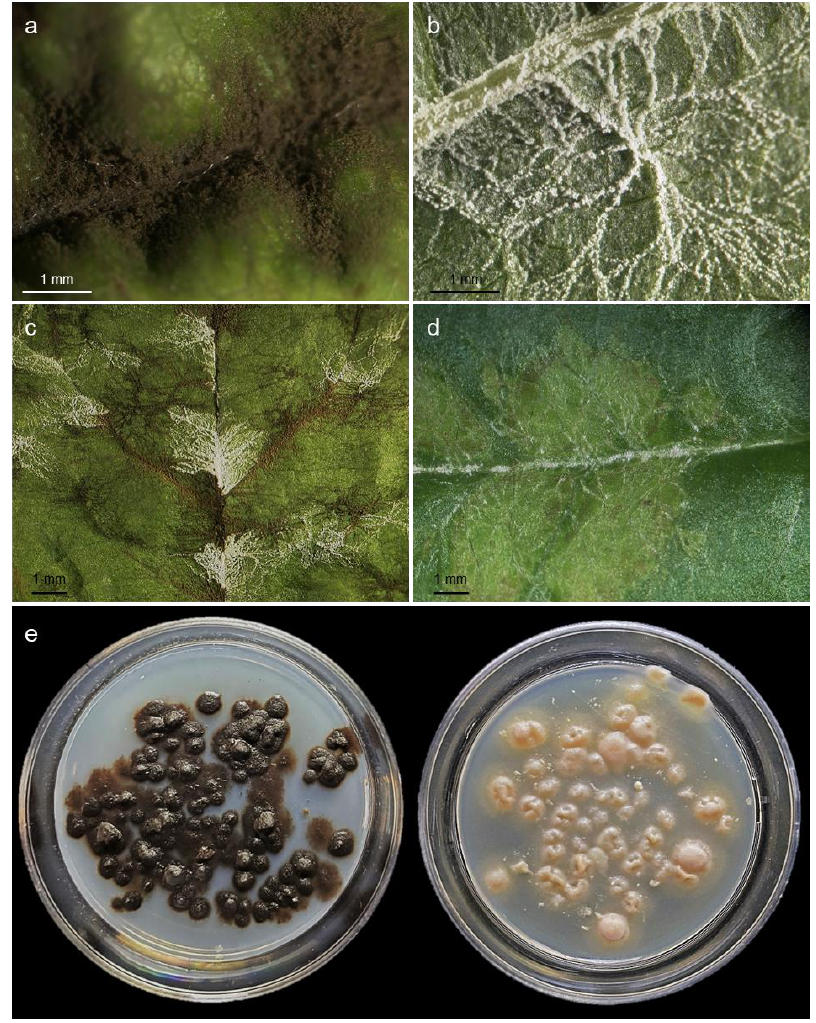
Figure 1. Symptoms of Venturia inaequalis isolate HS1 (wild-type; ( a , c )) and SW01 (melanin-deficient mutant, ( b – d )) on apple leaves. The wild-type produces large numbers of melanised conidia on the leaf surface, 10 dpi ( a ); the melanin-deficient isolate produces white conidia preferably on leaf veins, 10 dpi ( b ); sporulation of both isolates after mixed inoculation, 10 dpi ( c ); formation of conidia and chlorotic areas by SW01, 18 dpi ( d ). Pure cultures of HS1 ( left ) and SW01 ( right ) displaying the typical pigmentation of V. inaequalis mycelium on potato dextrose agar ( e ). On leaves of the scab-susceptible apple cv. ‘Cripps Pink’, the germination rate of isolate SW01 was no reduced 96 h p.i. and germtubes had almost double the length of germtubes